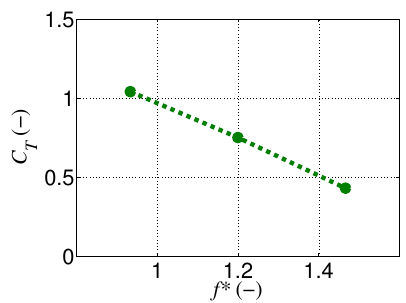
Figure 8. Variation of mean thrust coefficient with different f ∗ .